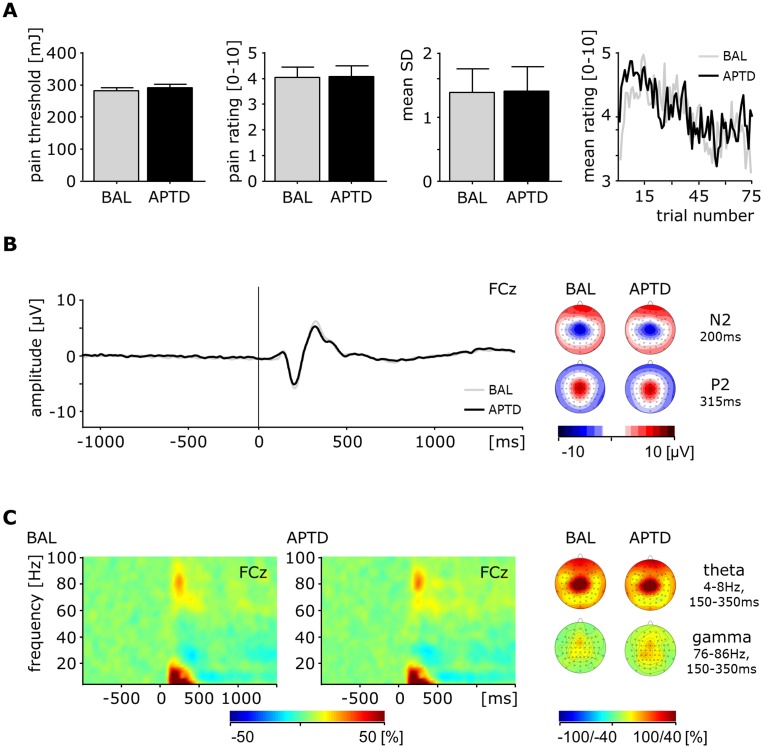
APTD does not alter pain sensation and neuronal responses to painful stimuli.(A) Pain thresholds, mean pain ratings, standard deviations of pain ratings, and time courses of pain ratings in the control (BAL) and depletion (APTD) condition. (B) Left, pain evoked potential at electrode FCz in the control and depletion condition. Right, scalp distribution of neuronal activity at 200 and 315 ms after painful stimulation in the control and depletion condition. (C) Left, group mean time-frequency representations of % signal change at electrode FCz after painful stimulation in the control and depletion condition. Right, scalp distribution of theta and gamma activity following painful stimulation coded as % signal change in the control and depletion condition.